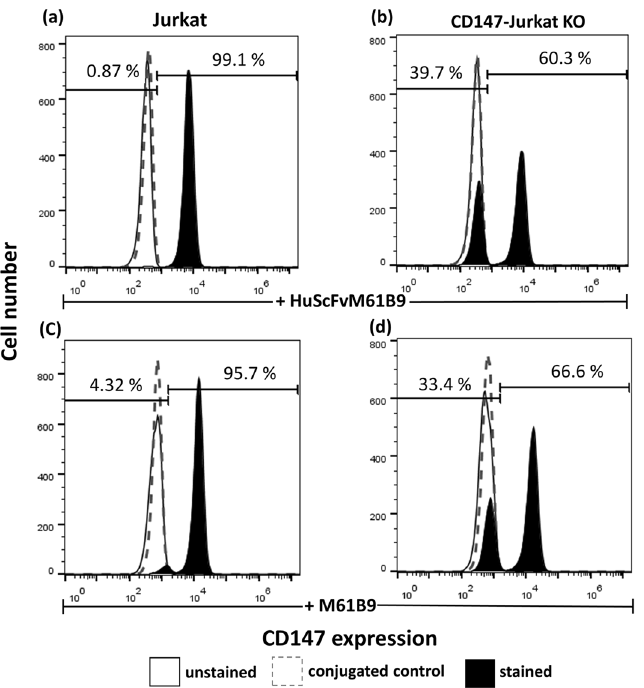
Figure 9. Specific binding activity of HuScFvM61B9. The Cas9 RNP delivery generated CD147 knockout Jurkat cells (CD147-Jurkat KO). Untransfected Jurkat and CD147-Jurkat KO cells were stained with HuScFvM61B9 ( a , b ) and M6-1B9 mAb ( c , d ), then followed by PE-conjugated anti-His tag antibody and Alexa Fluor 488 conjugated goat-anti-mouse IgG (H + L), respectively. Flow cytometric analysis was